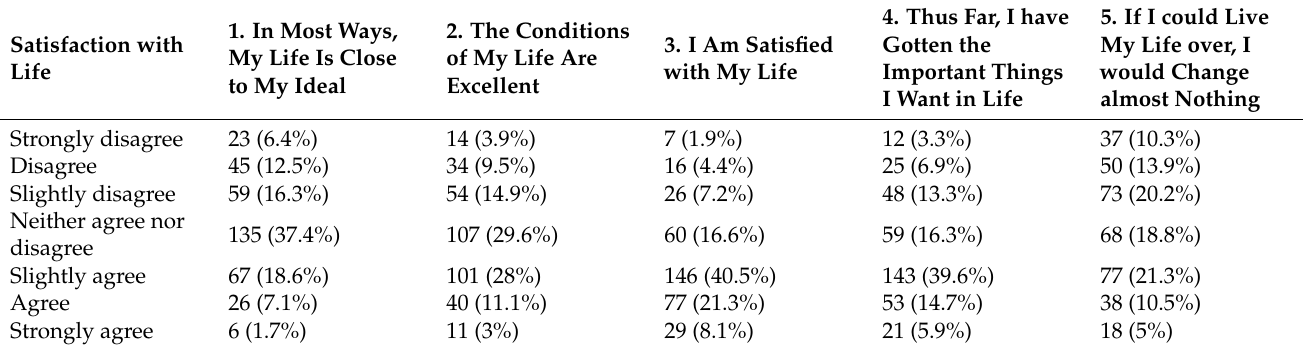
Table 2. The nurses’ responses to the statements in the Satisfaction with Life